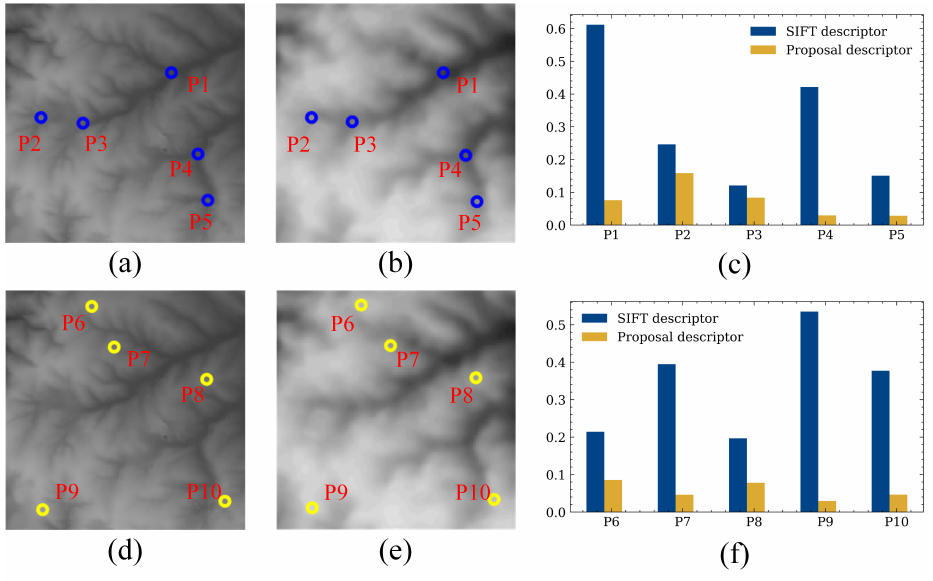
Figure 13. Comparison of improvement effects of descriptors. ( a , b ) Homonymous points of valley. ( d , e ) Homonymous points of ridge. ( c , f ) Euclidean distances of SIFT and the proposal descriptor.